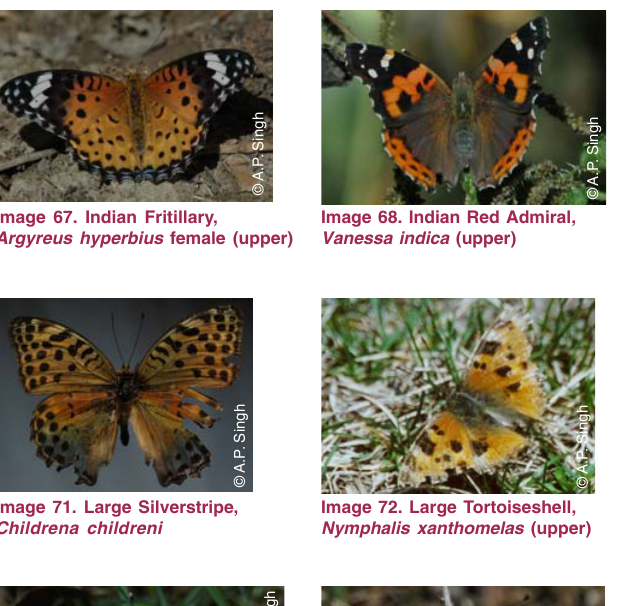
Image 71. Large Silverstripe, Childrena childreni